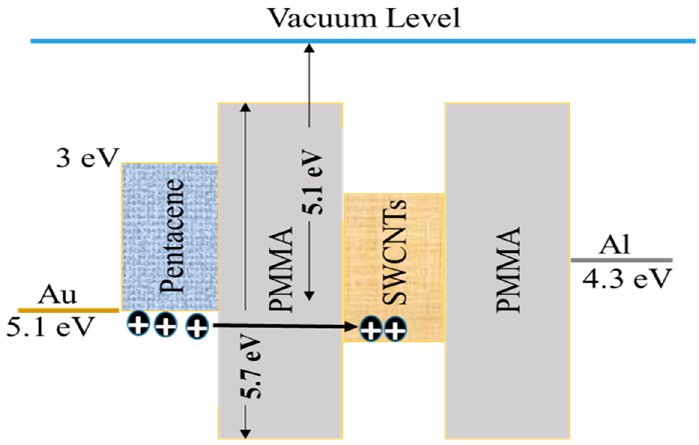
Figure 8. Energy band diagram of the SWCNT-based memory transistor.